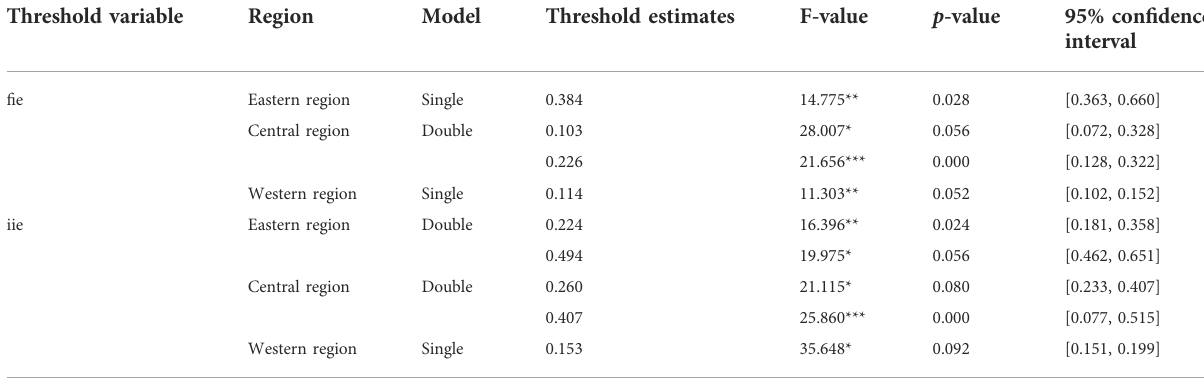
TABLE 9 Regional signi fi cance test and con fi dence intervals of institutional environments